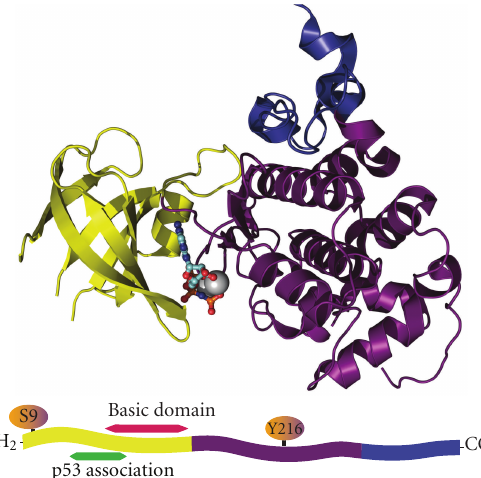
Figure 1: Glycogen synthase kinase-3 β (GSK-3 β ) structure. GSK- 3 β is a 433 residue protein consisting of 3 distinct structural domains. The N-terminal domain (yellow) consists of the first 134 residues and forms a 7-strand β -barrel. A short linker from the N-terminal domain, residues 135–151 connect the N-terminal domain to the α -helical domain (magenta). The α -helical domain is composed of residues 152–342. Sandwiched between the N- terminal and α -helical domain is the ATP-binding site. The C- terminal domain consists of residues 343–433 (blue). A strand diagram of GSK-3 β . Phosphorylation of Ser-9 inactivates the enzyme, while phosphorylation of Tyr-216 activates. The p53 association region and basic domain region are both located in the N-terminal domain. Image was made using PyMol Molecular Graphics Software version 1.3 with the PDB structure